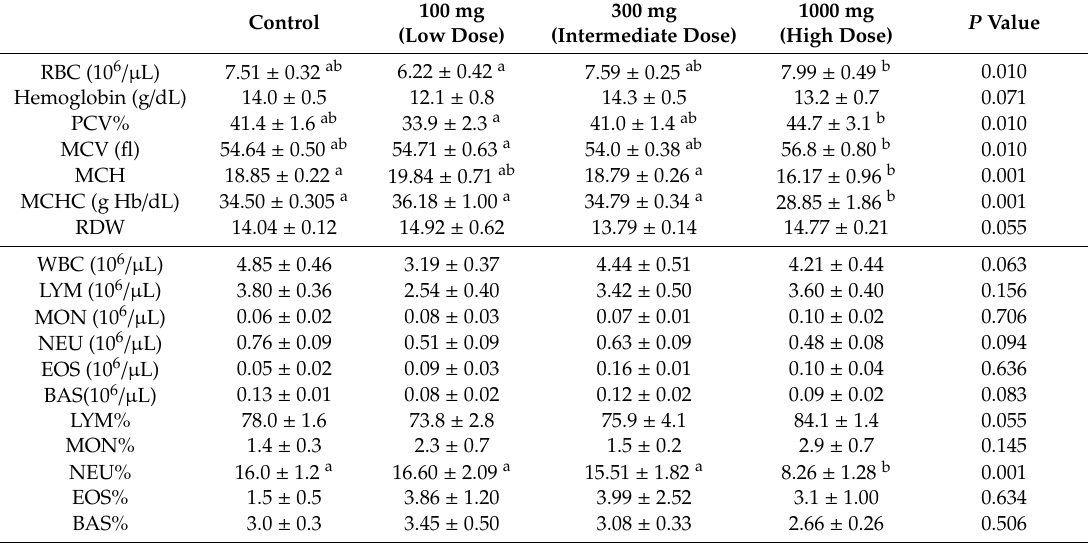
Table 2. Blood hematological parameters after 90 days of intervention with di ff erent doses of the VOO